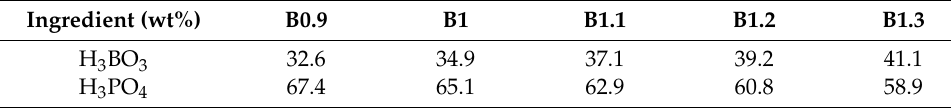
Table 1. Batch composition of the fabricated